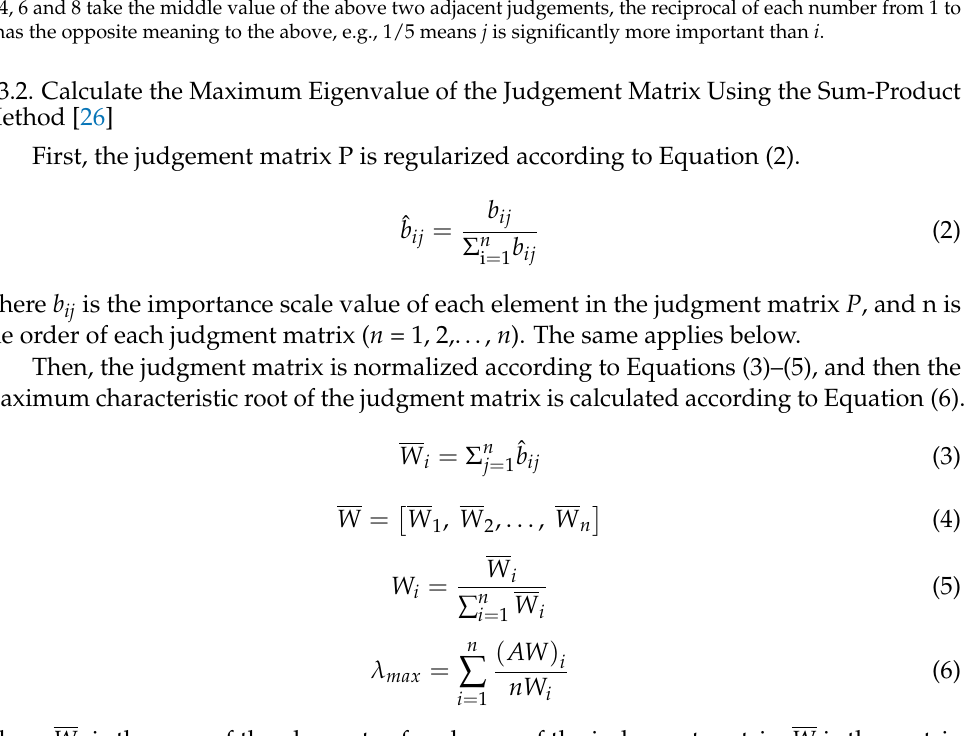
Table 1. Analytic Hierarchy Process Scale and Relative Importance Judgment. Element Scale Meaning 1 Factor i is of equal importance compared to factor j 3 Factor i is slightly more important than factor j b ij 5 Factor i is significantly more important than factor j 7 Factor i is strongly more important than j compared to factor j 9 Factor i is extremely more important than j compared to factor j 2, 4, 6 and 8 take the middle value of the above two adjacent judgements, the reciprocal of each number from 1 to 9 has the opposite meaning to the above, e.g., 1/5 means j is significantly more important than i